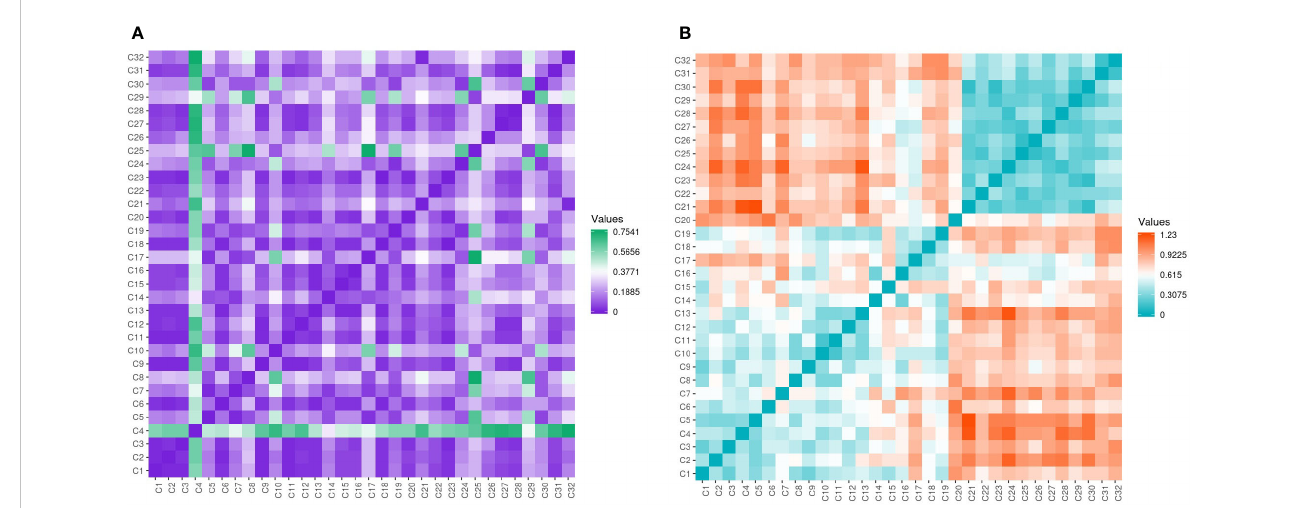
FIGURE 7 Gower ’ s dissimilarity matrix from the morphological data (A) and Pearson ’ s correlation matrix (B) from the molecular data of the Cyclamen genotypes. For the morphological data, green represents similarities, while purple represents dissimilarities. For the molecular data, orange represents similar genotypes, whereas turquoise represents the most dissimilar genotypes. As the matrices were symmetrical, the values below the crossways correspond to the values above.